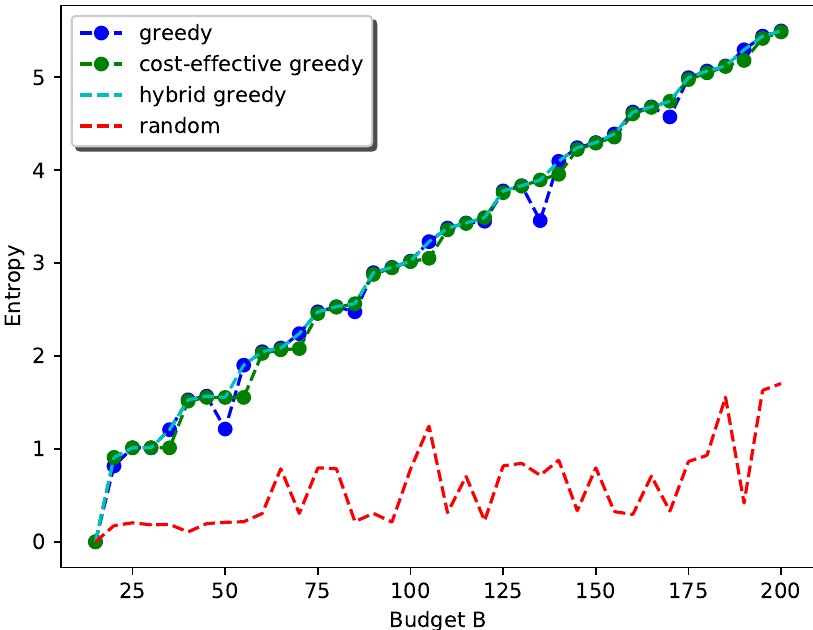
Figure 9. Performance of the hybrid greedy approach with a higher weight for PM 2.5 .